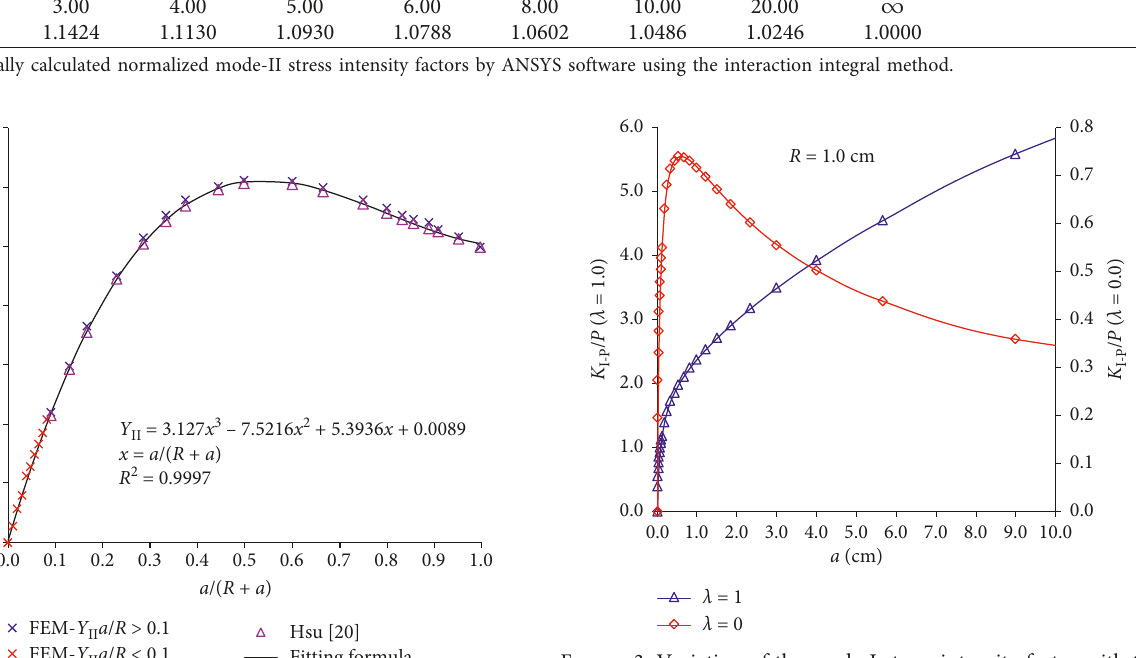
Figure 3: Variation of the mode-I stress intensity factor with the perforation